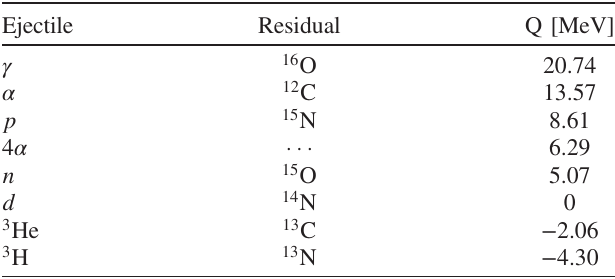
TABLE III. There are only seven channels open for beam energies below 5 MeV.